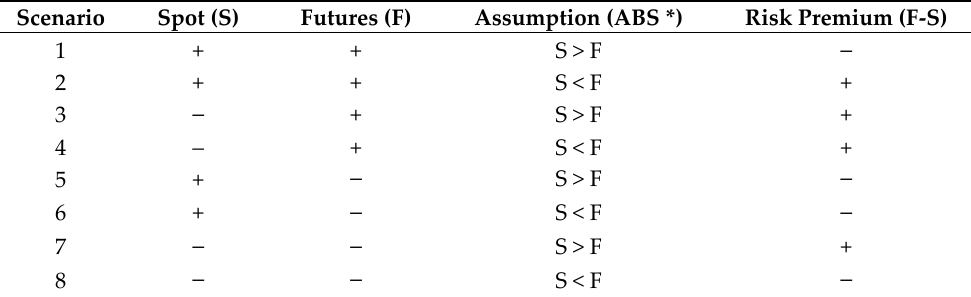
Table 3. Risk premia outcomes under given price